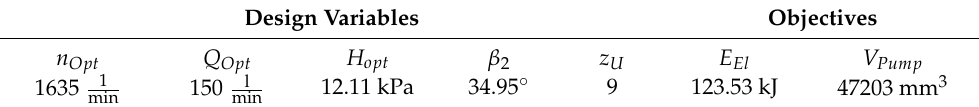
Table 3. Numerical values of the selected technical variant in Figure 18. Design